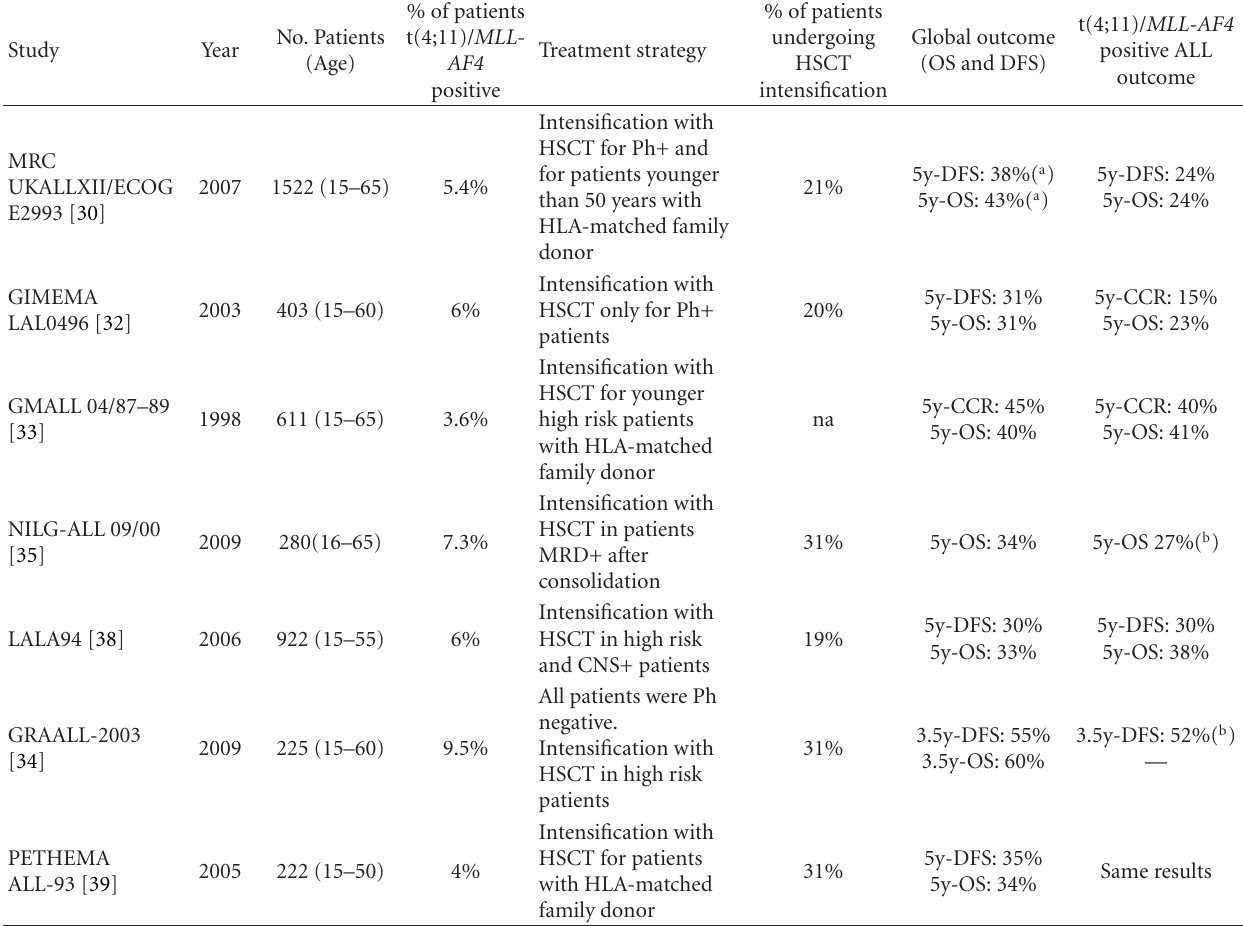
Table 4: Clinical outcome of t(4;11)(q21;q23)/ MLL-AF4 positive ALL in di ff erent cooperative trials